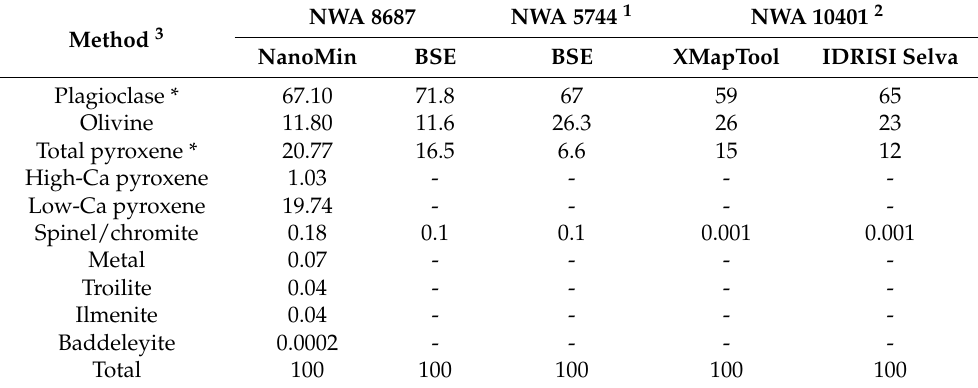
Table 1. Mineral modal abundance in the lunar meteorites NWA 8687 compared to pairs NWA 5744 and NWA 10401 (in vol. %).